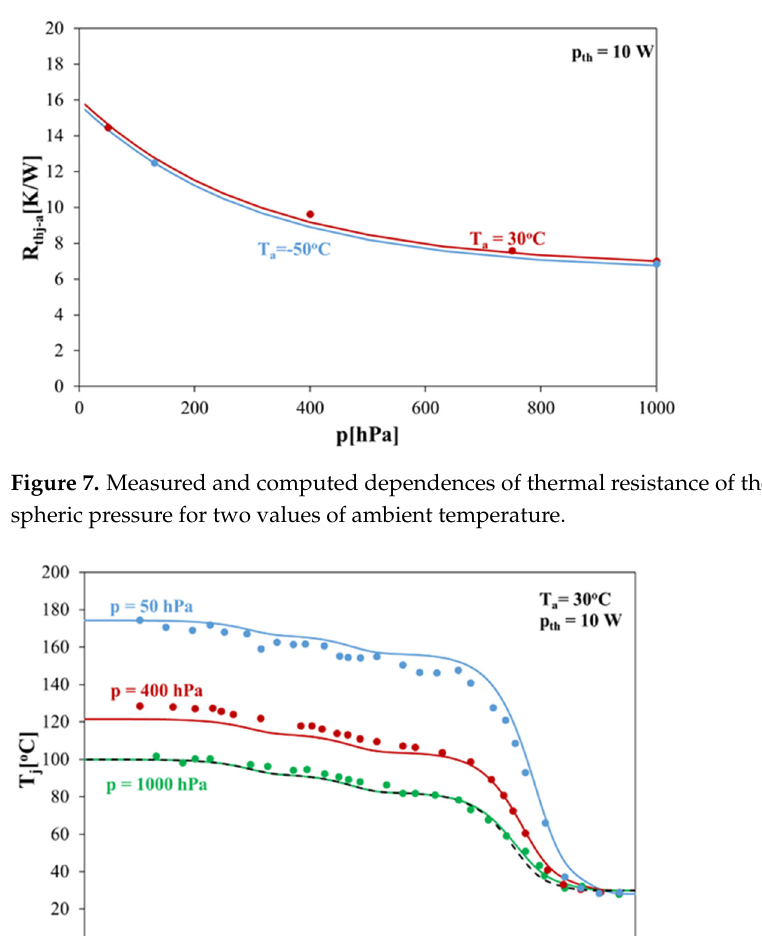
Figure 8. Measured and computed waveforms of the junction temperature of the tested diode for three values of atmospheric pressure.